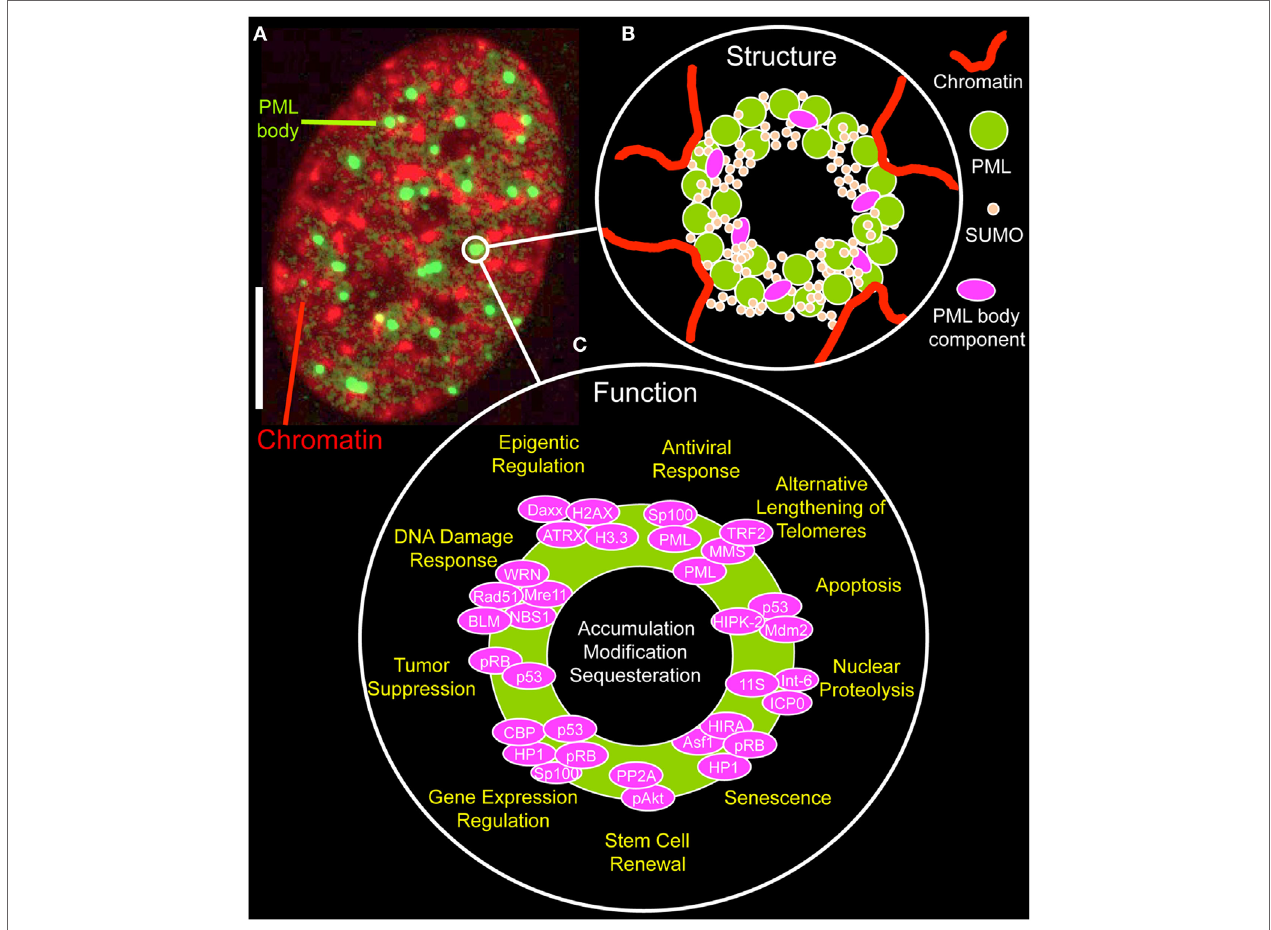
FigURe 2 | Structure and function of promyelocytic leukemia (PML) nuclear bodies. (A) Distribution of PML protein in a cell nucleus of a MRC-5 (primary human lung fibroblast) cell. The micrograph shows the immunofluorecence signal of an antibody directed to all PML isoforms (green, monoclonal antibody E-11, sc-377390, Santa Cruz Biotechnology, Heidelberg, Germany) along with DAPI fluorescence (red) of a mid-confocal section of the nucleus. Bar; 5 µm. (B) Structure of PML nuclear bodies. SUMOylated PML protein subunits are the building blocks of a shell-like structure in the periphery of the nuclear body. Additional PML body- interacting proteins may bind to PML, specifically to the C-termini of the various PML isoforms, to the poly-small ubiquitin-related modifier (poly-SUMO) chains or to SUMO-interaction motifs. PML nuclear bodies’ are in direct contact with chromatin fibers, which contribute to the bodies physical stability. See Figure 3 for more information on the assembly mechanism. (C) Proposed functions of PML nuclear bodies. Probably more than 100 proteins permanently or transiently bind to PML NBs. According to these protein’s function, many different physiological roles as depicted have been proposed for PML